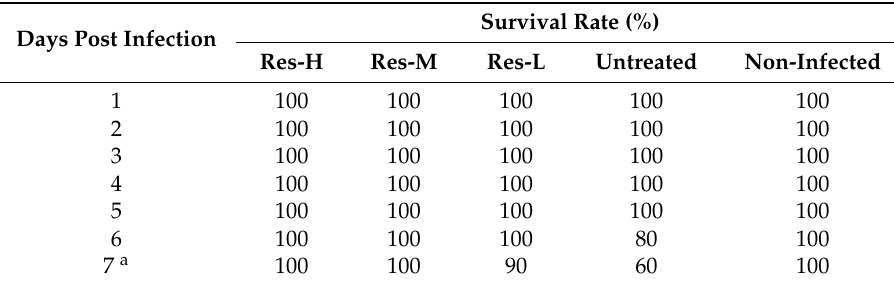
Table 1. Resveratrol treatment reduced the mortality of PRV-infected piglets. Survival Rate (%) Days Post Infection Res-H Res-M Res-L Untreated